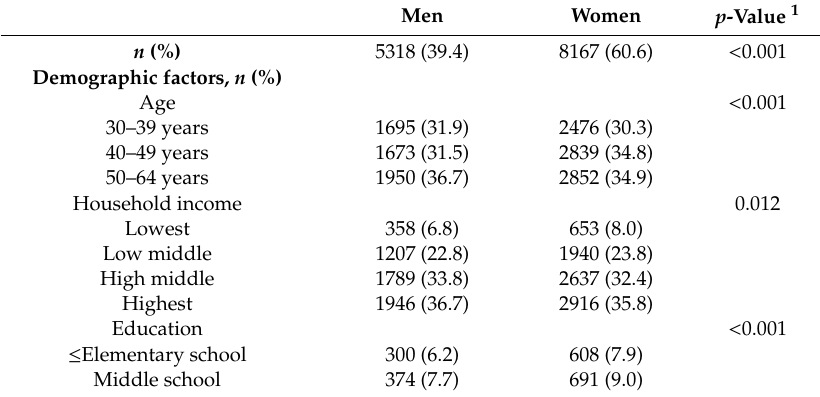
Table 1. General characteristics of study subjects by